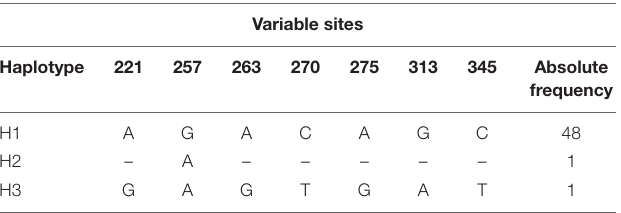
TABLE 2 | Variable sites of 350 bp of the mitochondrial DNA control region (D-loop) of franciscana ( Pontoporia blainvillei ) determining three haplotypes and their respective frequencies.